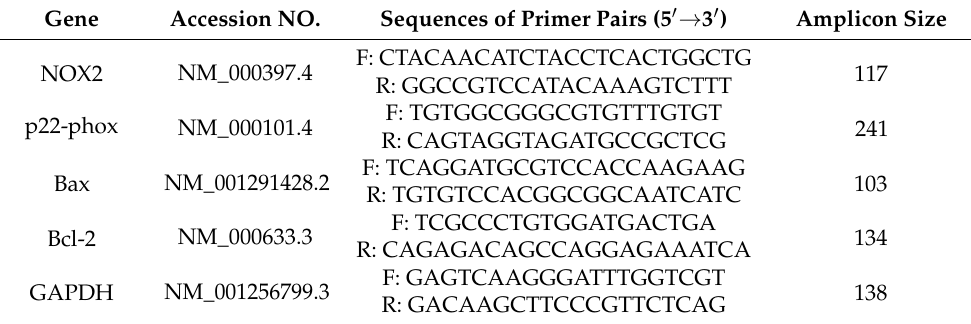
Table 1. Gene names, primer forward (F) and reverse (R) sequences, and amplicon size.